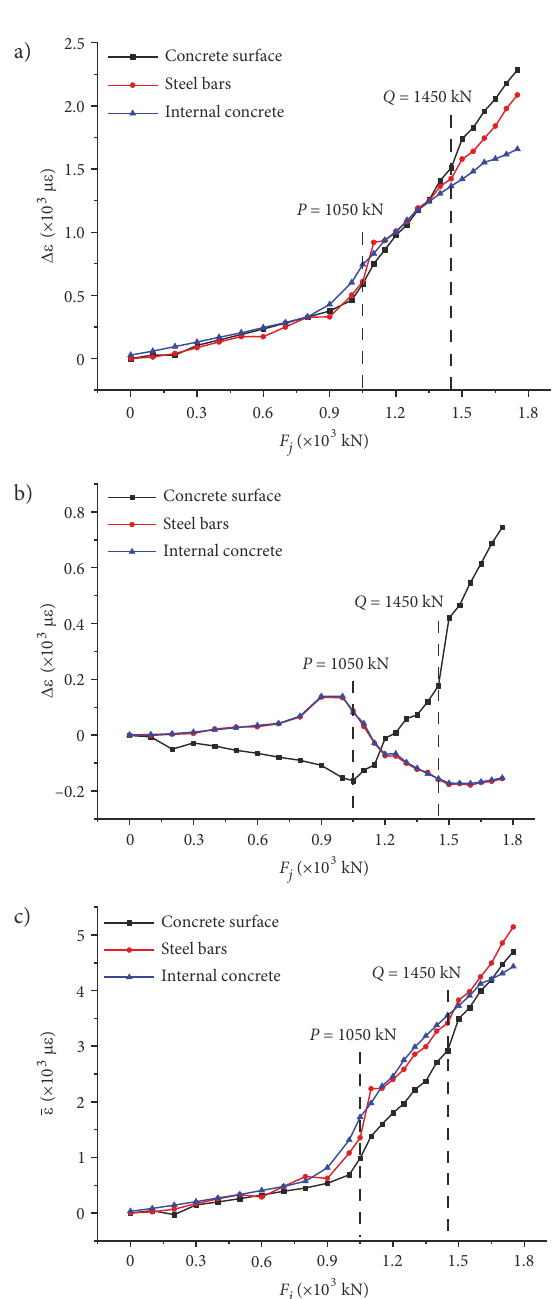
Figure 11. The changing features of generalized internal forces: (a) generalized in-plane bending; (b) generalized out-plane bending; (c) generalized axial